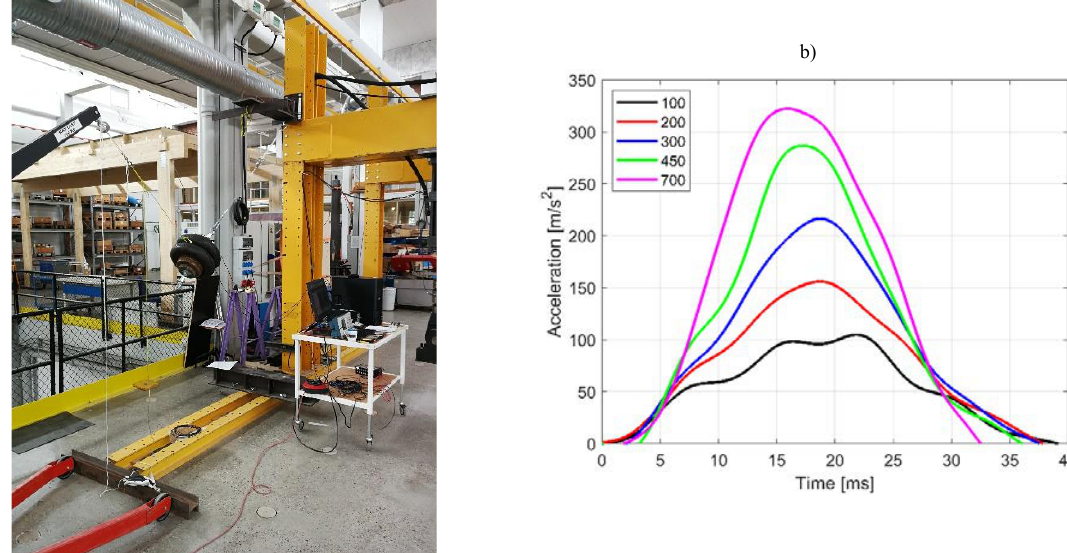
Fig. 5 Dynamic characterization of the impactor: a) test set-up, b) average histories of the impactor’s acceleration released from different drop heights. The experimental results obtained in the study have a good correlation with the reference values. The 6% difference was likely caused by the differences in the test set-ups. In the reference studies (Müller de Vries 2012), the impactor hit a reinforced concrete wall with a presumably higher stiffness than the steel column used in the current study. In